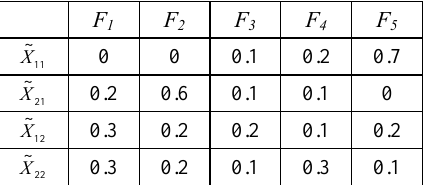
Table 1. Distribution of fuzzy similarities of products with fashion